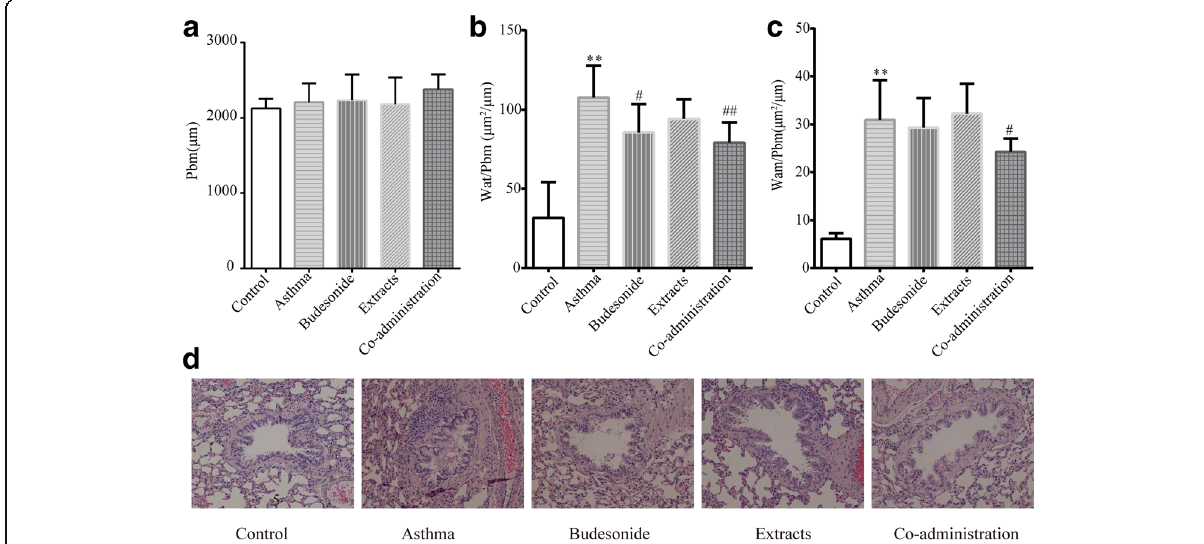
Fig. 1 Effects of budesonide and the herbal extracts on airway remodeling. Pbm ( a ), Wat/Pbm ( b ), and Wam/Pbm ( c ) in H&E-stained lung sections. ( d ) Representative photomicrographs of H&E-stained lung sections from each group (×400); Mean ± SD, n = 10. ** P < 0.01compared to normal control group; # P < 0.05 and ## P < 0.01compared to asthma model